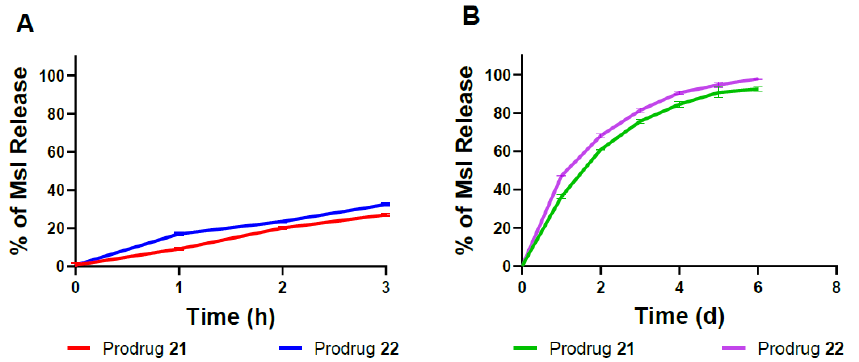
Figure 5. The correlation of the free Msl release to time for 250 µ M of Msl prodrugs 21 and 22 ( A ) when incubated in PBS/H 2 O (1:1 v/v, pH 7.5) and ( B ) when incubated at pH 6.5 in PB/H 2 O (1:1 v/v, pH 6.5). All the experiments were at 37 °C. Values were recorded in triplicate. Error bars are S.E.M.